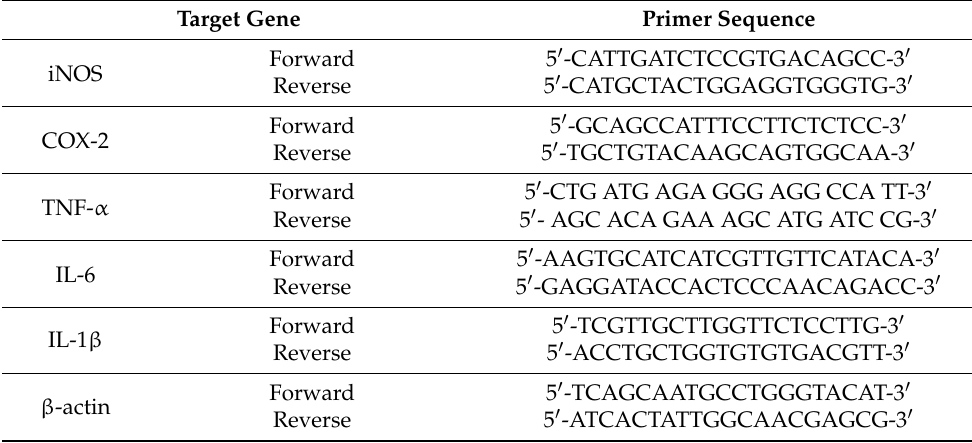
Table 2. Primer sequences used for quantitative real-time PCR